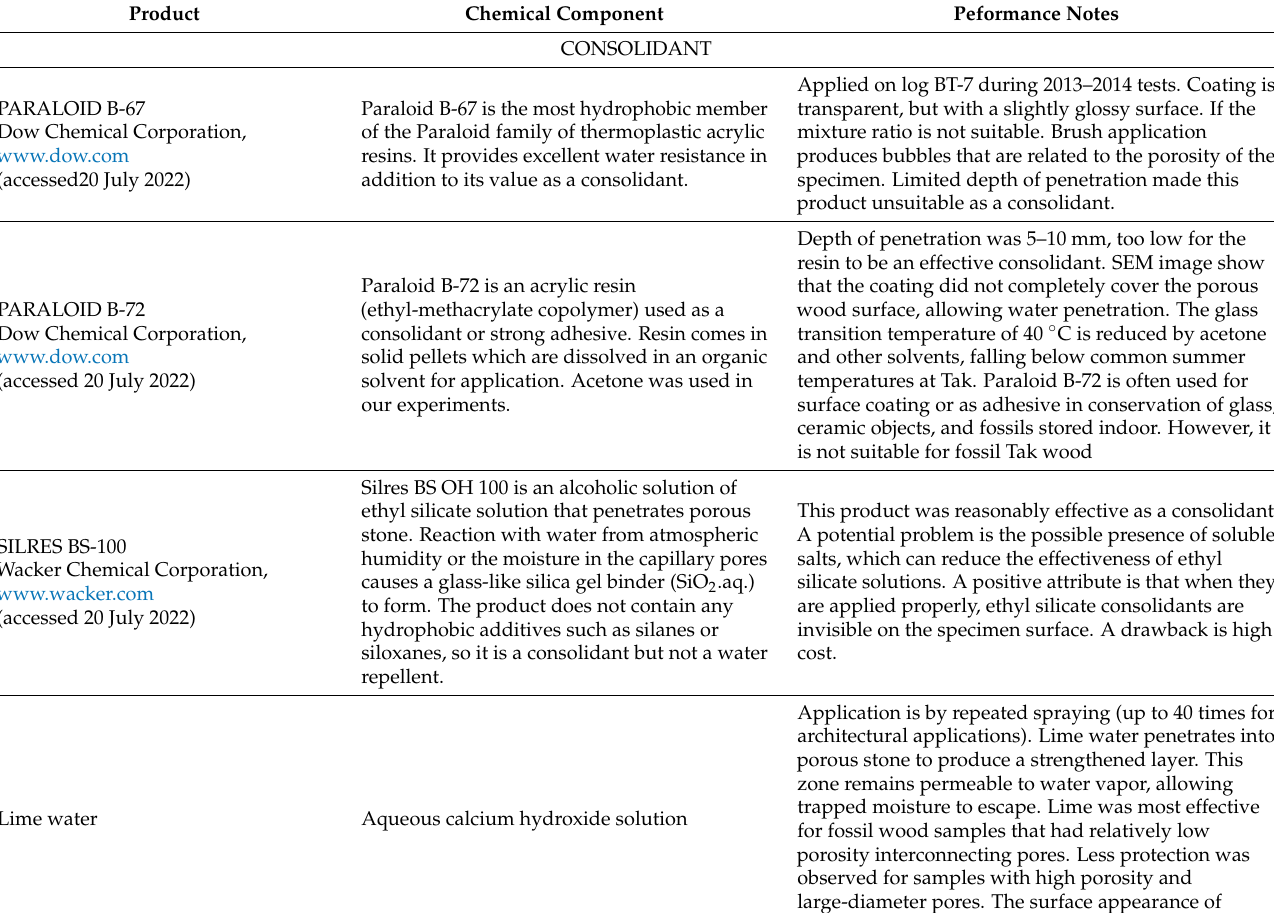
Table 4. Performance characteristics of experimental chemical treatments used at